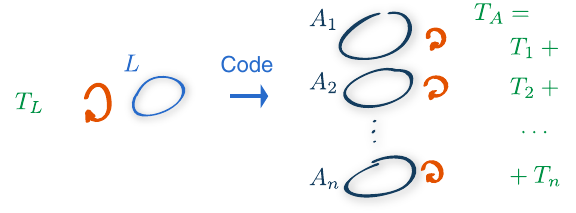
FIG. 1. Quantum information represented on an abstract logical system L is encoded on several physical subsystems A 1 … A using a code. Suppose that the code is compatible with a continuous transversal symmetry, for instance, rotations in 3D space. This compatibility means that by rotating all individual physical subsystems one induces the same transformation as if one had simply rotated the initial logical system L . No such